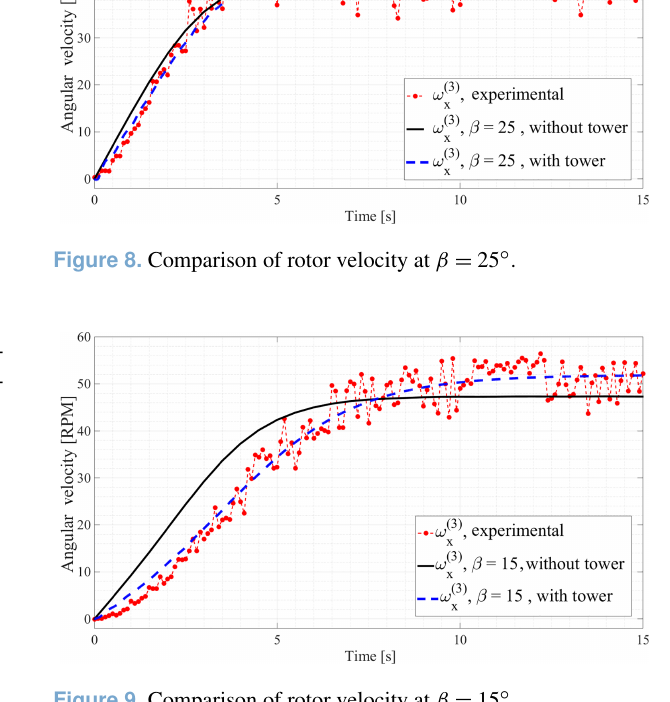
Figure 7 shows the comparison between the simulation of transverse displacement R (2) y of the nacelle and the exper- imental data. The working parameters are as follow: twist angle β = 25 ◦ , wind speed v 2 = 8 m s − 1 , three modes to de- scribe the movement of the tower, and six 3-D beam element to construct each blade model. The convergence between the two curves indicates the validity of the selected modal coor- dinates of the tower and the overall mathematical model of the wind turbine